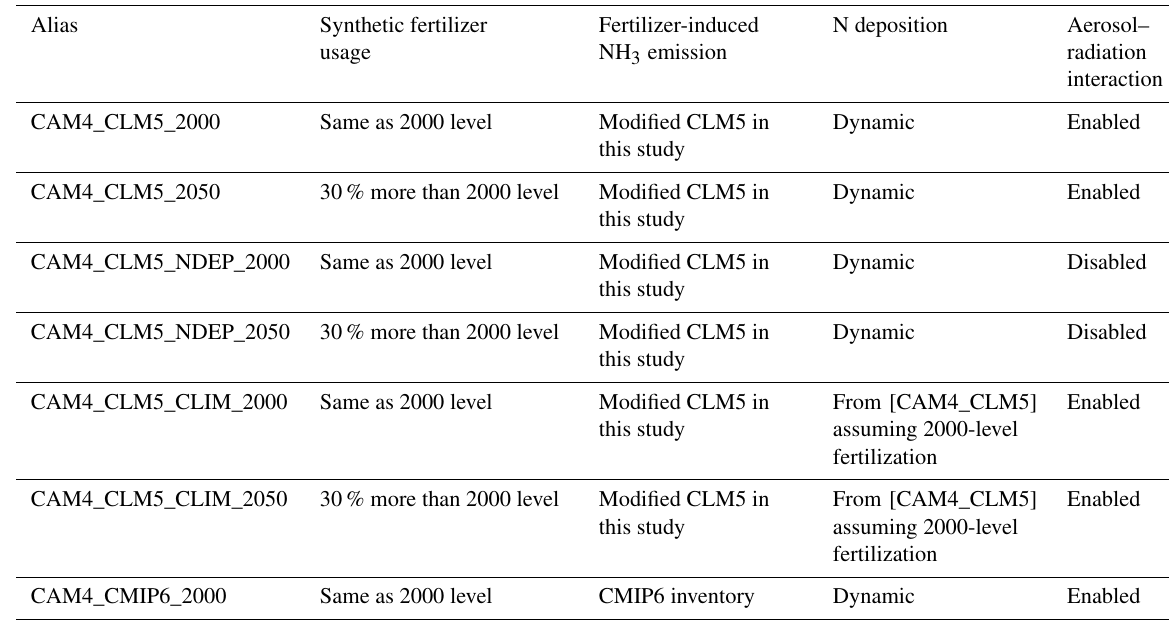
Table 1. Details of simulation designs.